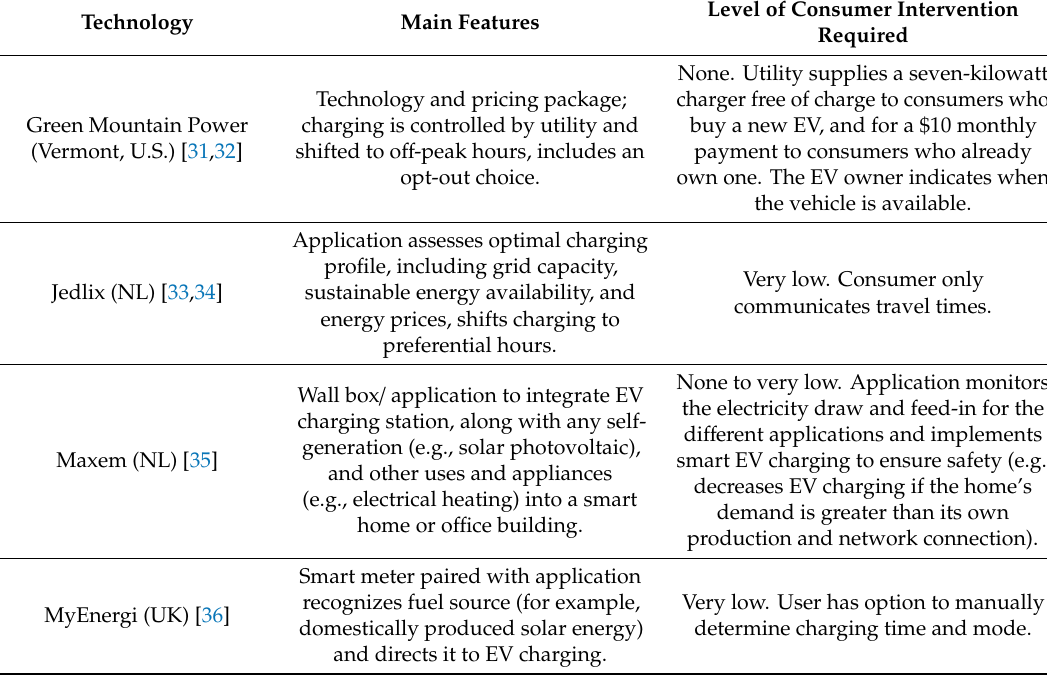
Table 2. Examples of smart technology